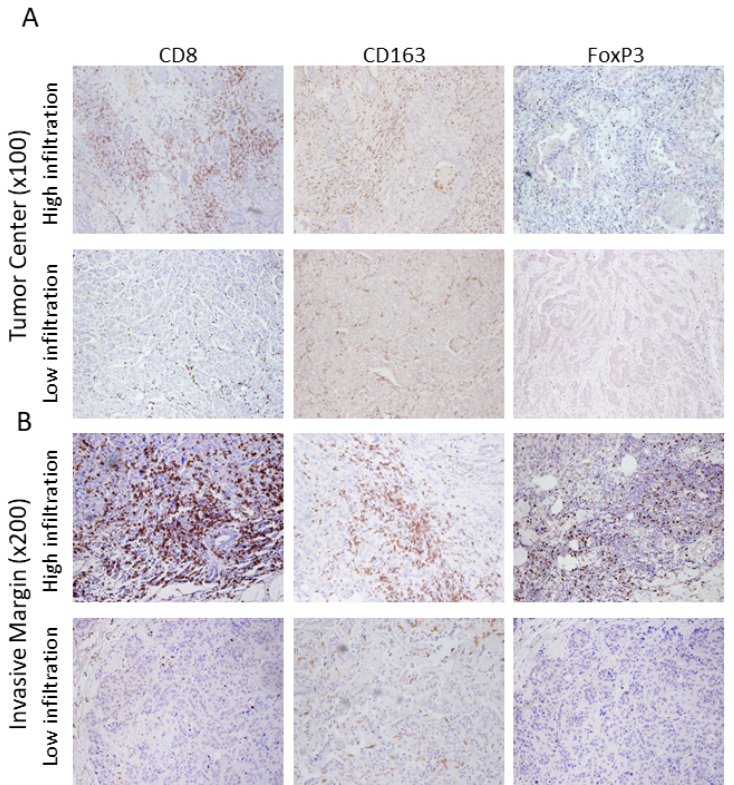
Figure 1. Immunohistochemically stained images of tumor compartments ( A ) Tumor Center ( × 100) and ( B ) Invasive Margin ( × 200) infiltrated with CD8+ and FoxP3+ cells and CD163+ macrophages.